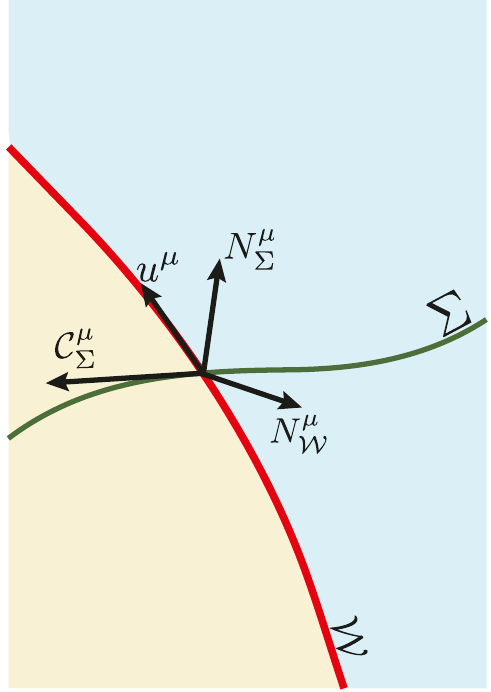
Figure 4 . Con(cid:12)guration of relevant vectors at the intersection sphere S W = (cid:6) \ W